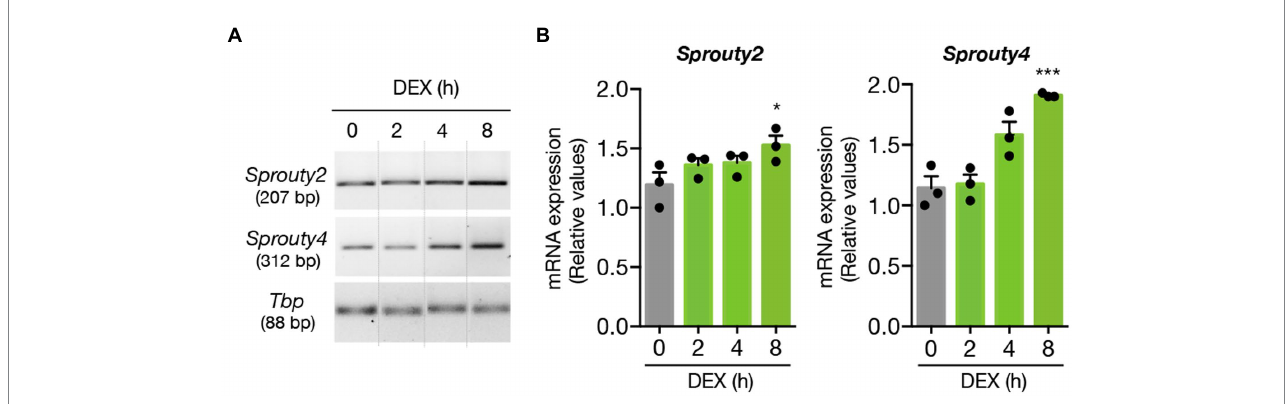
FIGURE 4 DEX promotes the expression of Sprouty2 and Sprouty4 mRNAs in hippocampal primary neurons. (A) Semiquantitative RT-PCR analysis of Sprouty2 and Sprouty4 mRNA expression. Hippocampal primary cultures were treated with DEX (1 μ M) for different time-points. For each molecule, the PCR amplification product size is indicated in base pairs (bp). Dotted lines indicate representative bands cut from the same PCR gel image. (B) Bar graphs showing the induction profiles of Sprouty2 and Sprouty4 mRNAs at different time points upon DEX stimulation. The levels of mRNAs were normalized to the expression of the housekeeping gene Tbp . Values are presented as relative to the untreated control group (t = 0 h DEX, gray bar). The results are shown as mean ± s.e.m. of n = 3 independent assays. * p < 0.05, *** p < 0.001, by one-way ANOVA followed by